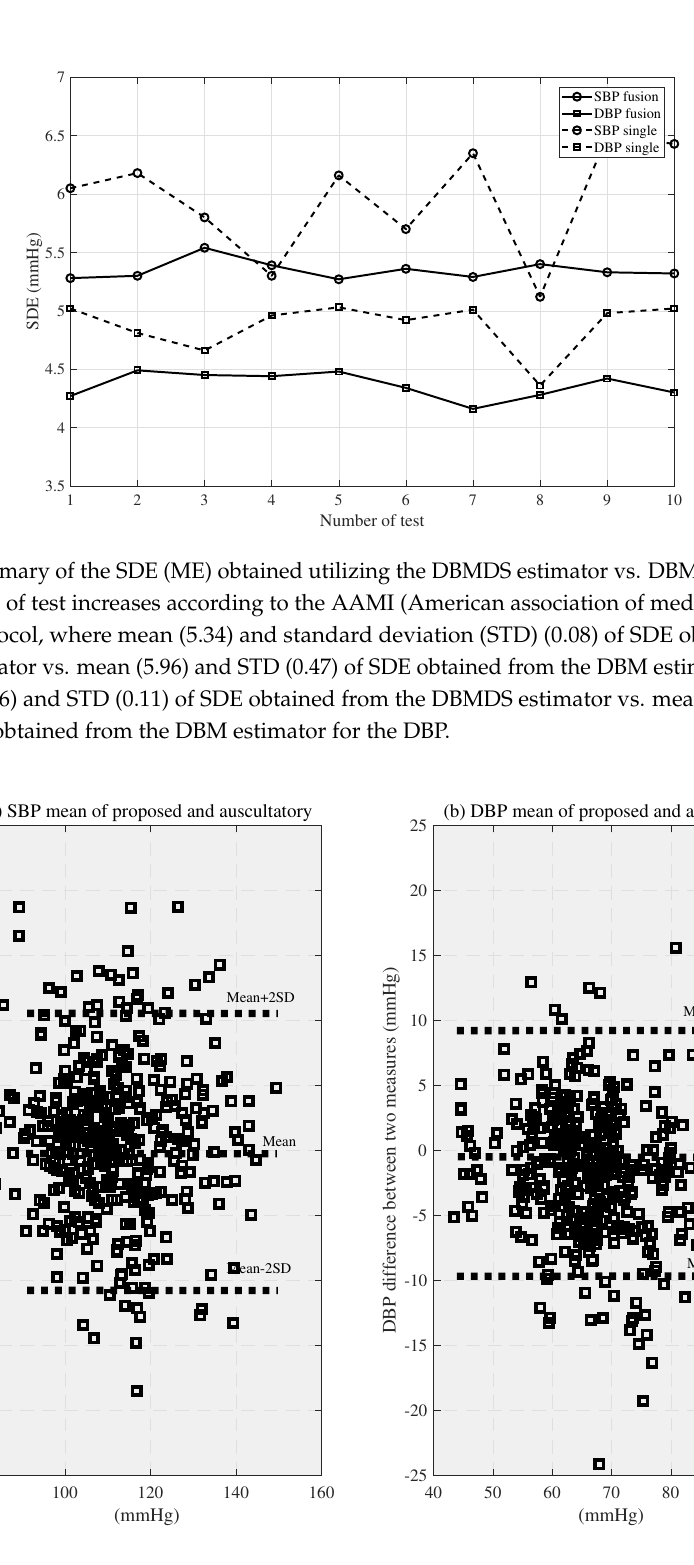
Figure 6. Performance comparison between new fusion technique and stethoscope nurse measurements using the Bland–Altman method [5,12,19]. ( a ) Bland–Altman plot for the SBP; ( b ) Bland–Altman plot for the